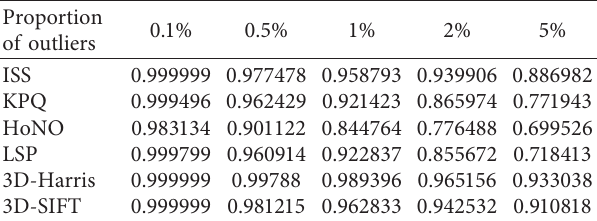
of the key point de- outlier